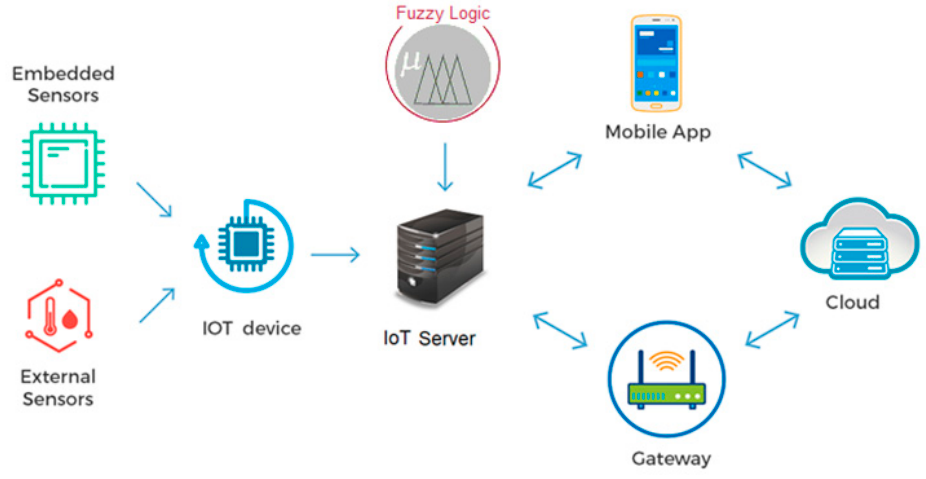
Figure 2. Smart irrigation system for tunnel farming.